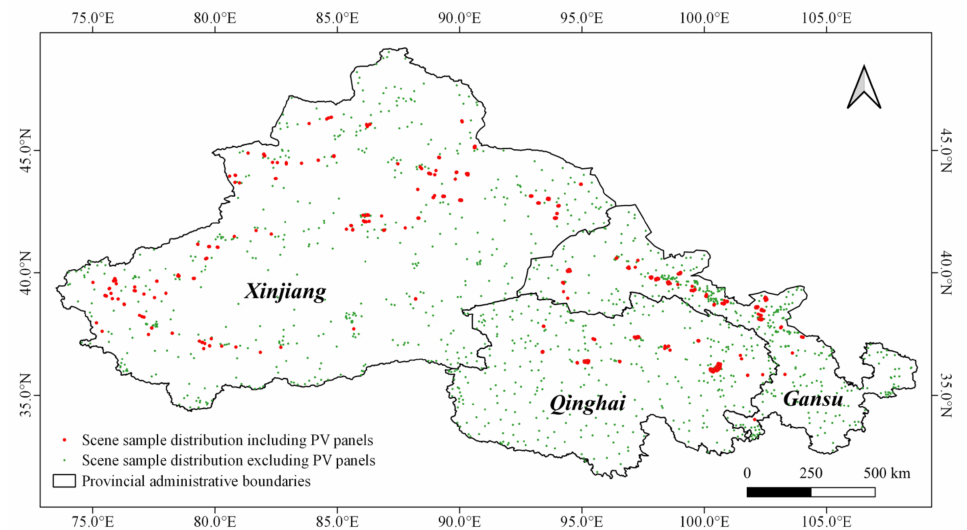
Figure 3. Sample distribution map for scene classification